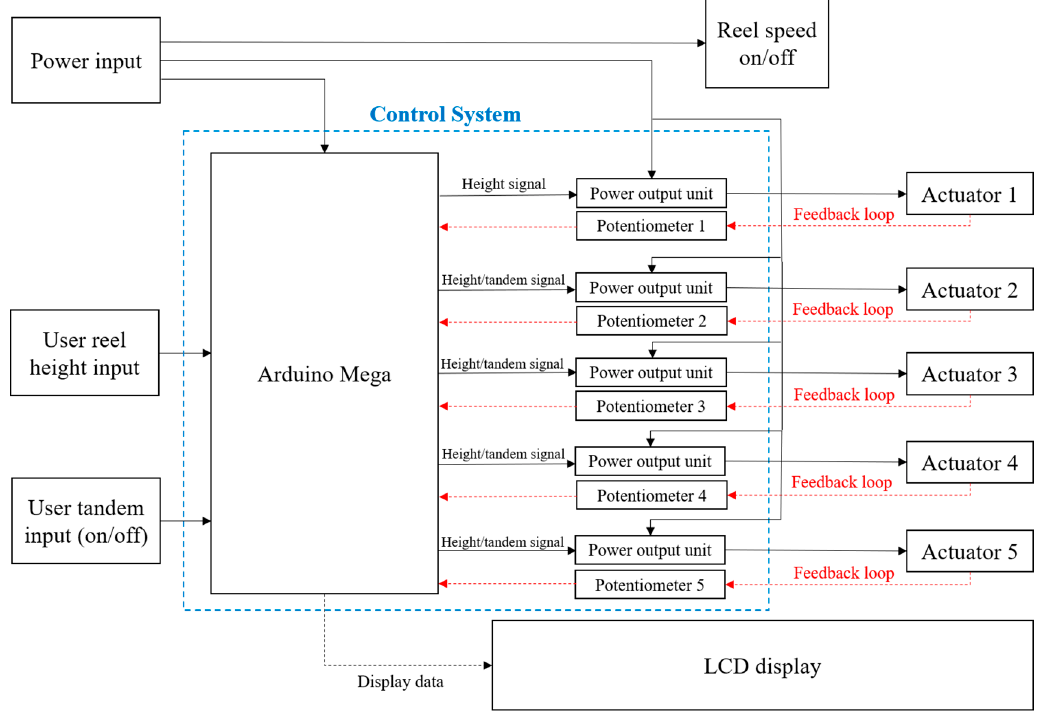
Figure 1. Block diagram of developed control system showing user input to microcontroller and feedback from each potentiometer for reel height positioning on DBE wild blueberry harvester.